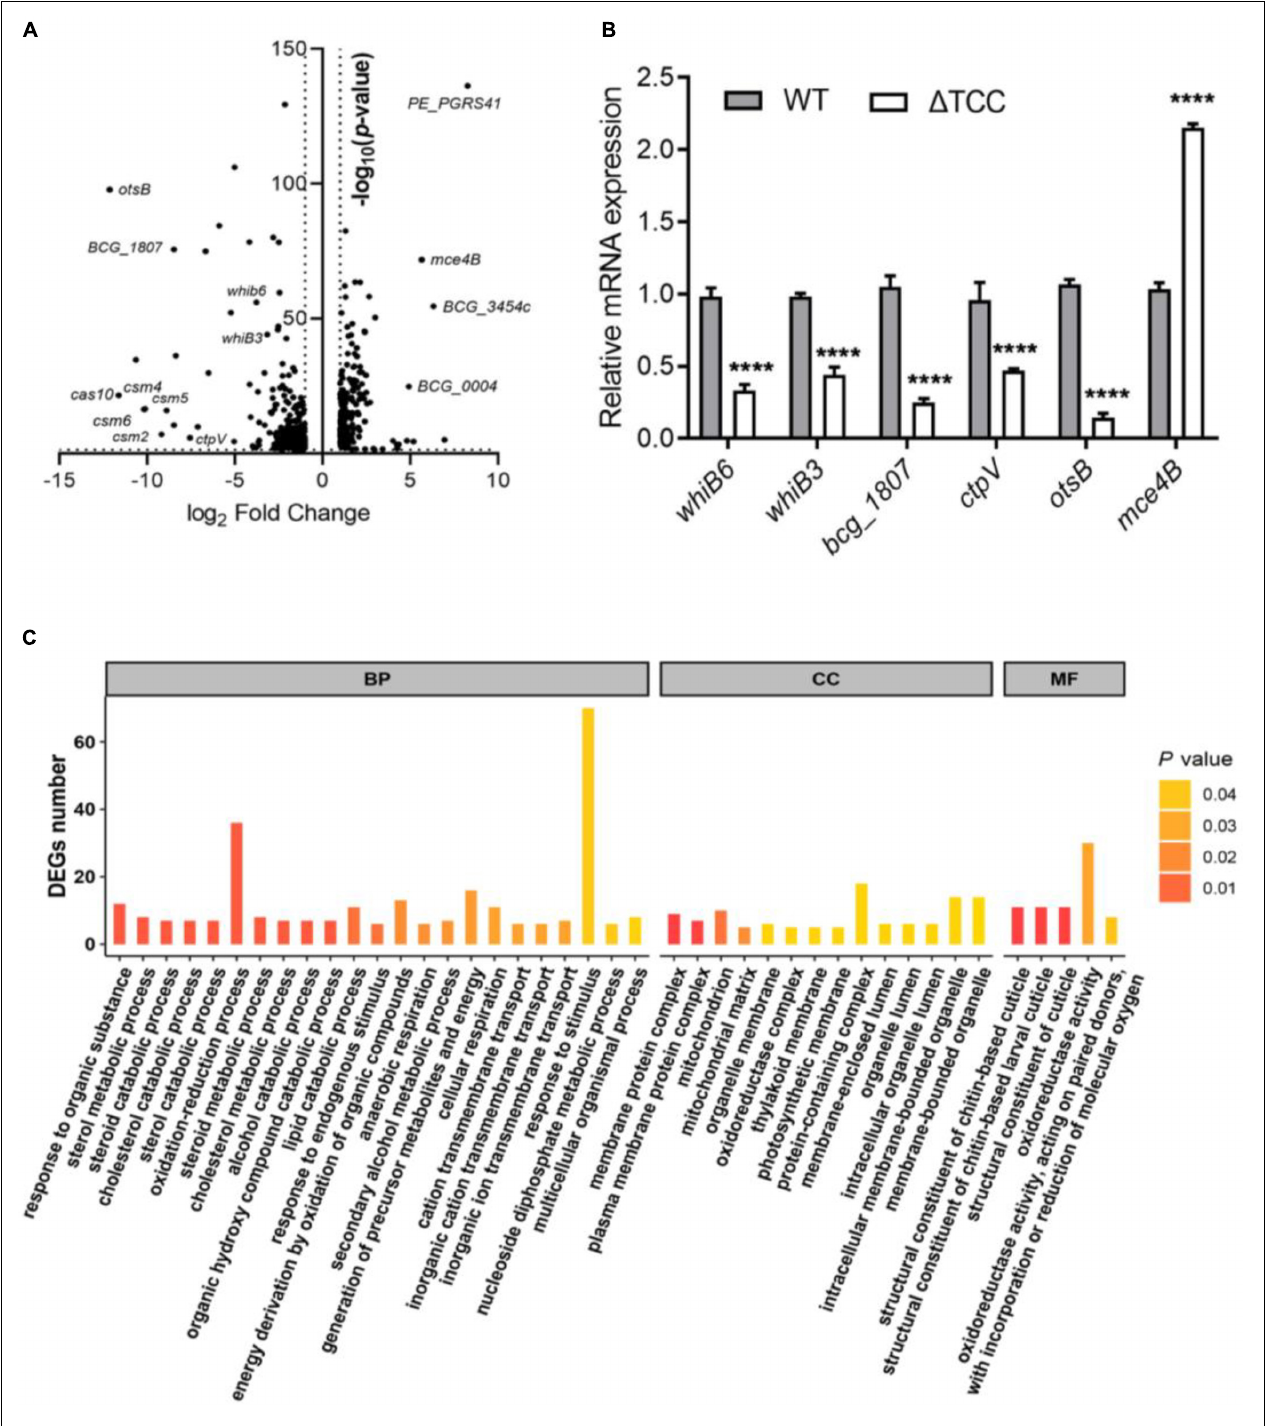
FIGURE 3 | Gene-expression differences between WT and (cid:49) TCC. (A) The volcanic diagram of gene expression difference between WT and (cid:49) TCC strains determined by RNA-seq. The significantly upregulated and downregulated genes [ p ≤ 0.05 and | log 2 fold change ( (cid:49) TCC/WT) | ≥ 1] were shown. (B) The mRNA level of differential genes was tested by qRT-PCR. WT and (cid:49) TCC strain were grown to log phase, the bacterial pellet was harvest for mRNA detection ( n = 3 biological replicates per group, data are shown as the mean ± SEM, two-way ANOVA with Tukey’s multiple comparison test, compared with control group; **** p < 0.0001). (C) Gene ontology (GO) annotations of differentially expressed genes and classification graph of GO terms for differentially expressed genes. GO includes the molecular function (MF), cellular component (CC), and biological process (BP).